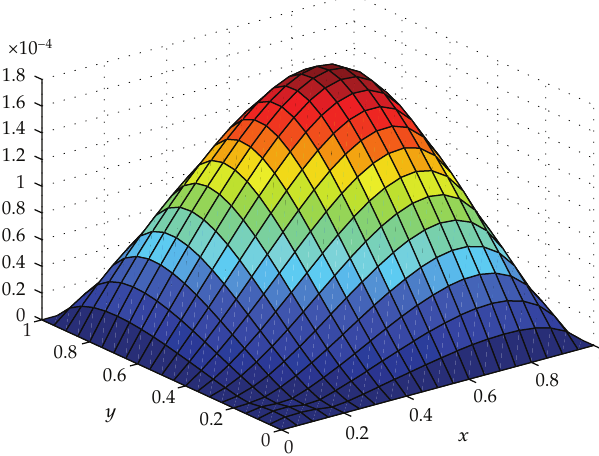
Figure 2: Absolute error at T (cid:9) 1, h (cid:9) 0 . 05, and Δ t (cid:9) 0 .